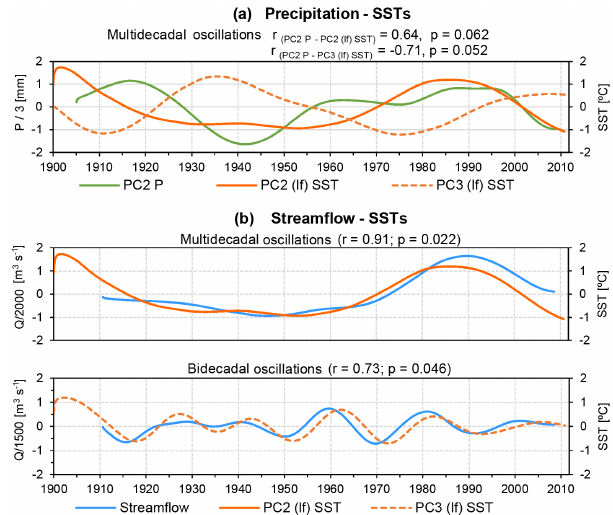
Figure 7. Time series of the dominant modes of regional hydrocli- mates variables and the leading patterns of global SSTs at decadal- to-multidecadal timescales. The description of the modes is given in Tables 1 and 2: (a) Multidecadal oscillations in PC2 SST, PC3 SST and PC2 P. (b) Multidecadal oscillations in streamflow and PC2 (top panel); bidecadal oscillation in streamflow and PC3 SSTs (bottom panel). The term r denotes the Pearson correlation coefficient be- tween series. Significance levels ( p values) for r are estimated by combining 2000 Monte Carlo iterations considering autocorrelation by resampling in the frequency domain (Macias-Fauria et al.,